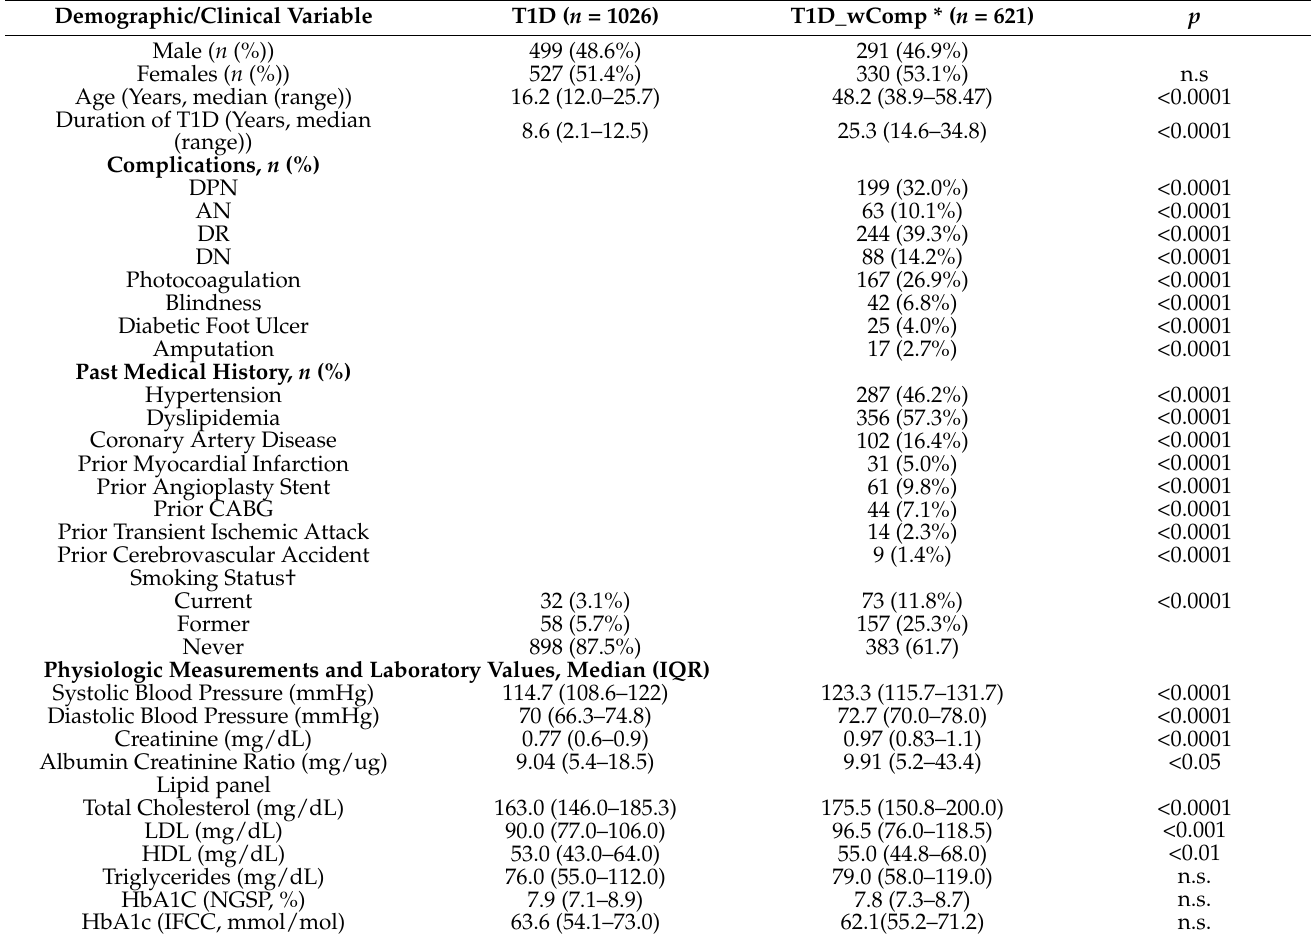
Table 1. Demographics and clinical data of Caucasian subjects with type 1 diabetes ( n = 1647) enrolled in PAGODA study. Demographic/Clinical